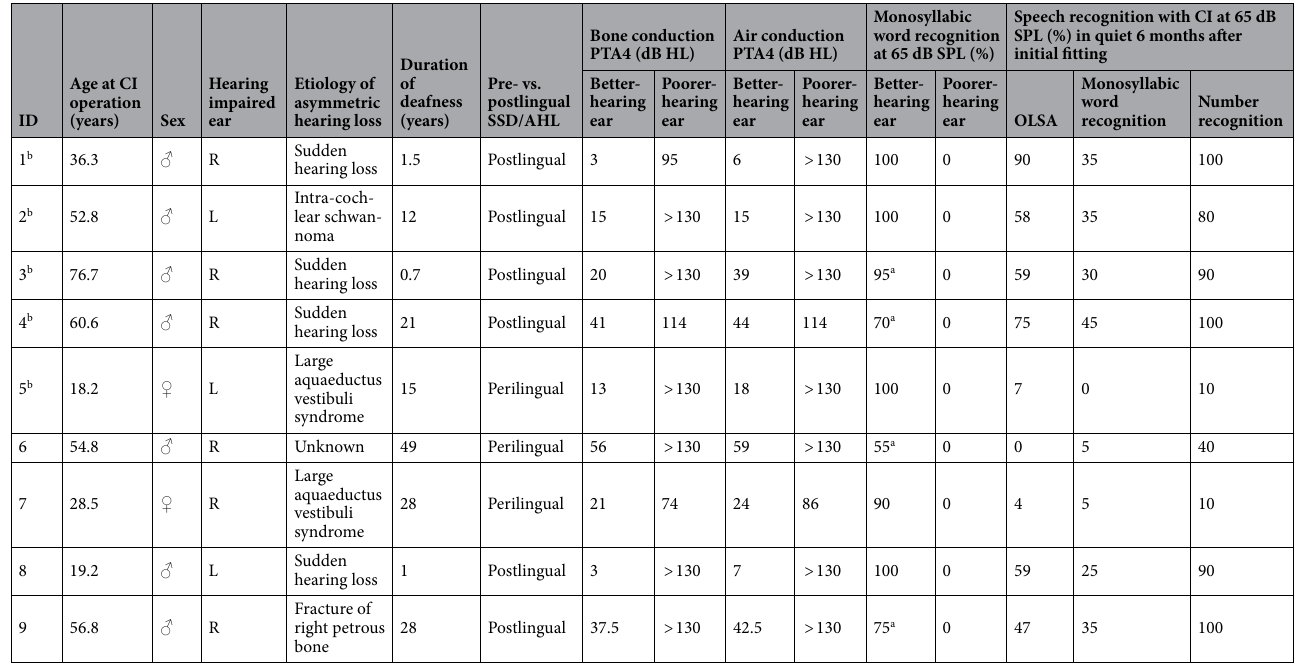
Table 1. Results of the audiological tests along with the demographic characteristics of the included patients. a Hearing aids used on the better-hearing ear. b Subjects reported in Speck et al. 20